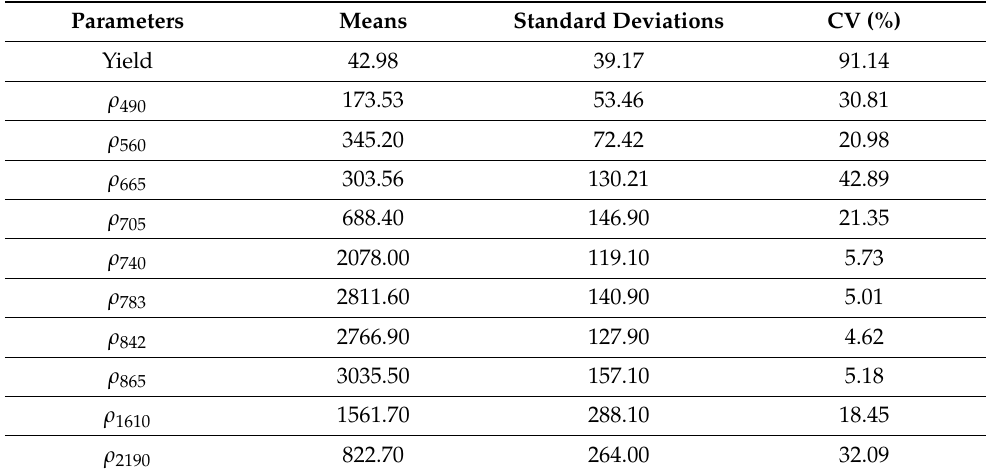
Table 3. Means, standard deviations and coefficients of variation (CV) of the coffee yield and reflectance of the bands of the Sentinel 2